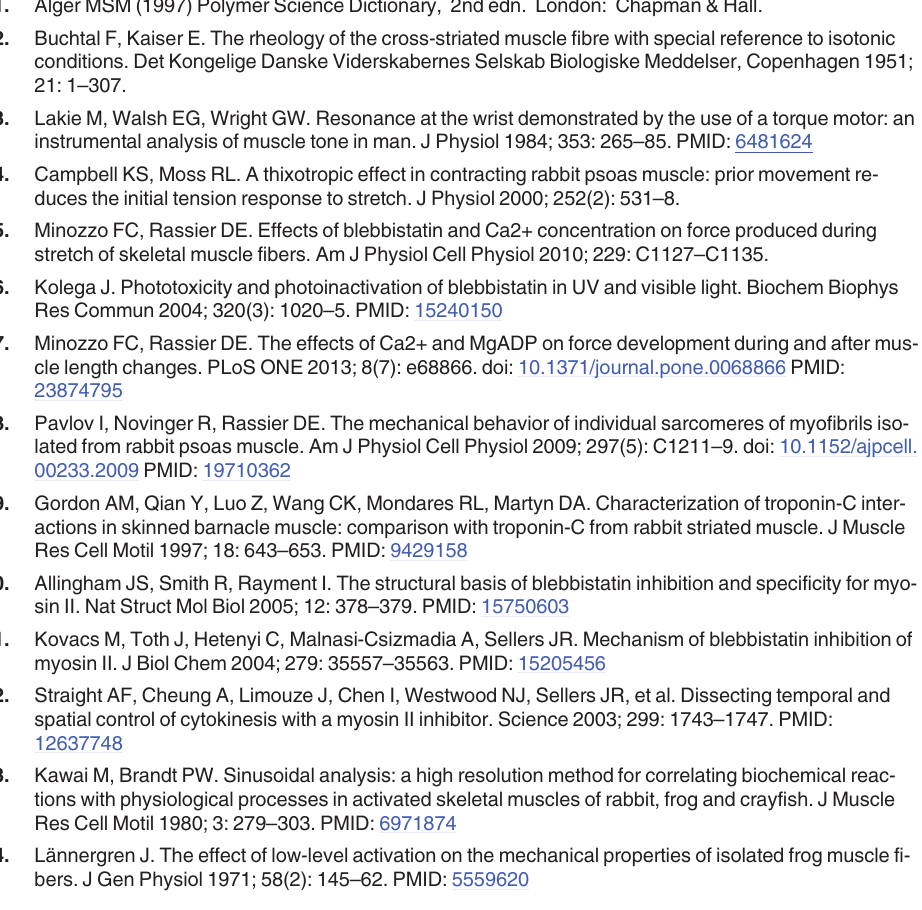
S6 Fig. Simulated force-response of a half-sarcomere to a 30 Hz length oscillation. The sim- ulation is described in detail in the text, and the parameters used are found in Table 1. The sim- ulation was run with the temperature in Equation (4) set to 310 K (blue), 293 K (red), and 278 K